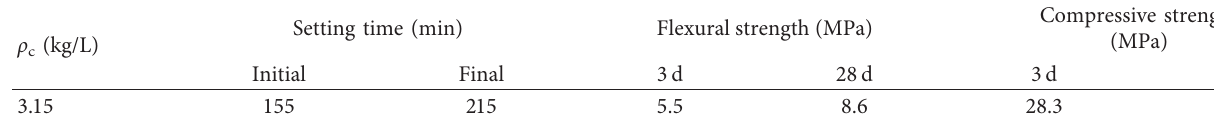
Table 1: Main performance indexes of reference cement.